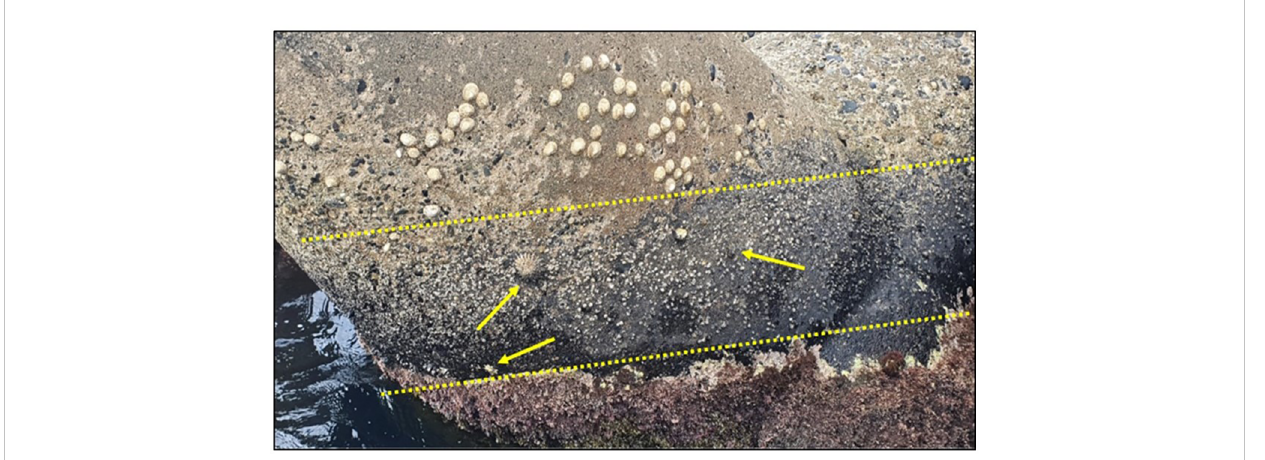
FIGURE 4 The dashed parallel lines delimit the strict strip of the upper midlittoral of the intertidal zone where P. ferruginea lives in the Strait of Gibraltar and nearby Mediterranean areas of the Alboran Sea. The upper line is the lower limit of the limpet P. rustica (in the image) and the lower line is the upper limit of the red alga Ellisolandia elongata , both very well de fi ned in the